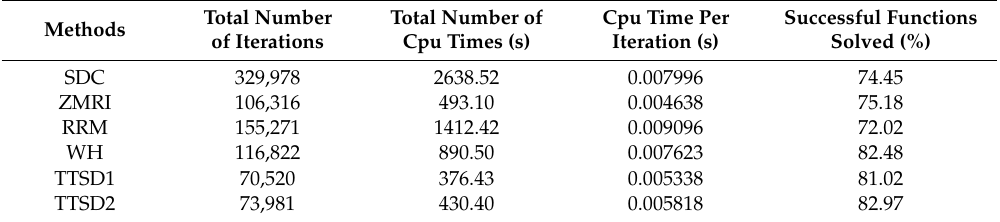
Table 2. CPU time (in seconds) per single iteration and successful percentage in solving all the functions using the exact line search.